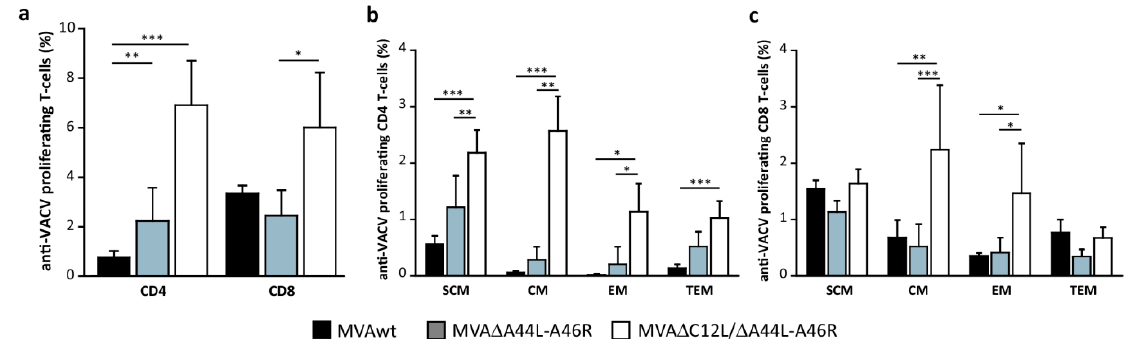
Figure 6. Analysis of the proliferation capacity of memory T-cells. ( a ) Splenocytes from MVAwt, MVA ∆ A44L-A46R or MVA ∆ C12L/ ∆ A44L-A46R immunized mice were labeled with CFSE, stimulated with UV-inactivated VACV and stained with CD4 or CD8, CD44 and CD62L. Percentage of specific proliferating CFSE low T-cells was determined by flow-cytometry. Cells were classified in four memory subpopulations (as detailed in Figure 5b), corresponding to CD4 + ( b ) or CD8 + ( c ) T-cells. Data are representative of three independent experiments. Statistical analysis performed by one-way ANOVA and Bonferroni’s post-test. Significant differences: * p < 0.05, ** p < 0.01, *** p < 0.001.